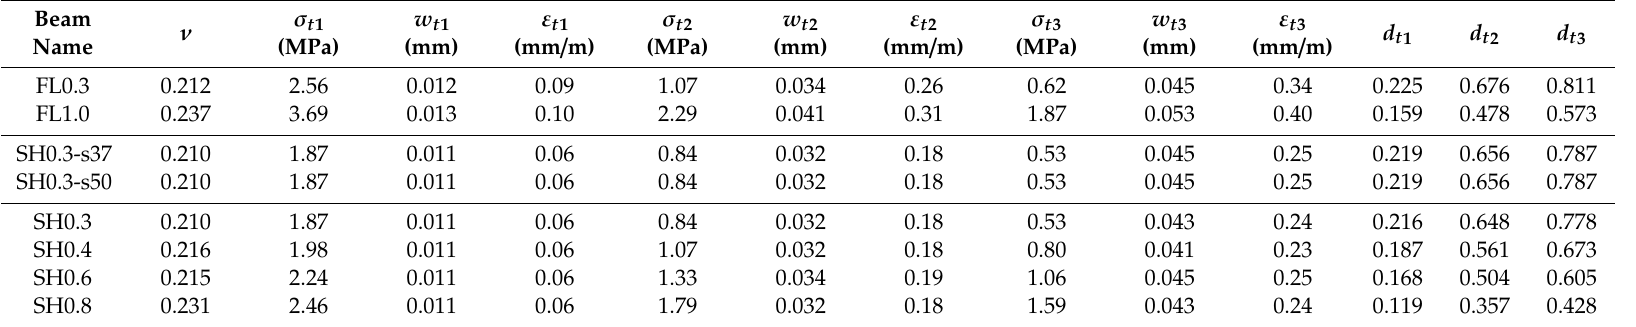
Table 4. Supplementary input variables for the simulation of the tested SFRC